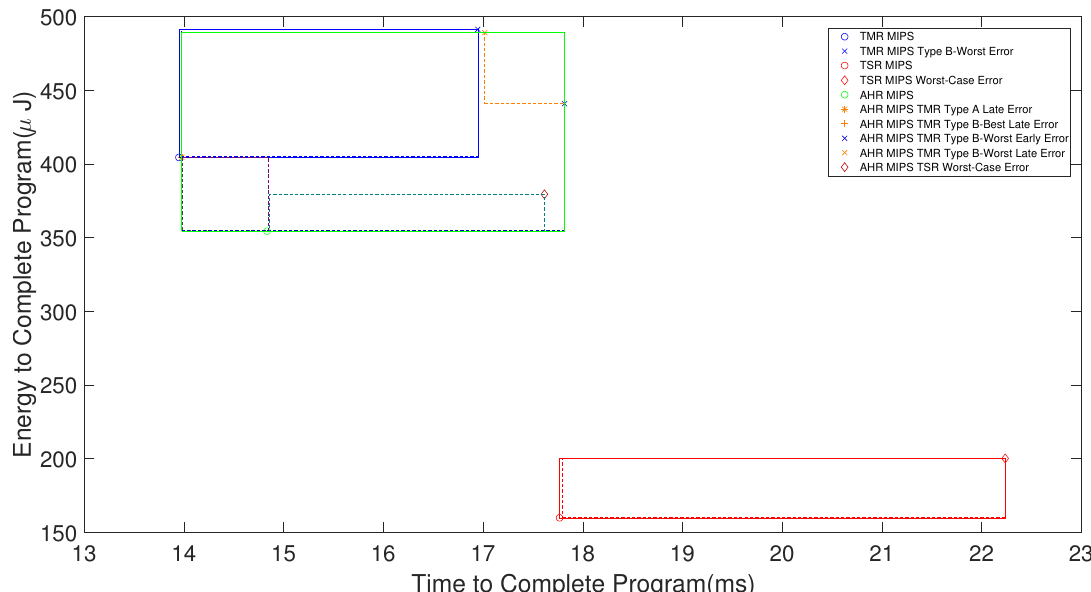
Figure 11. Average performance bounds for AHR MIPS with a TMR to TSR point at 40,000 instructions.